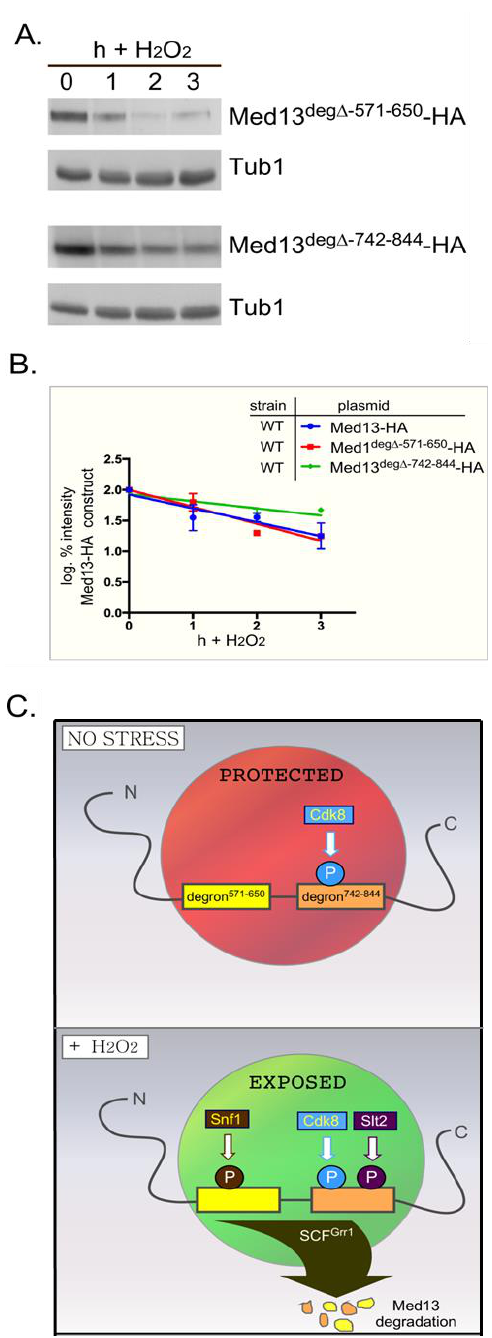
FIGURE 8: Either Med13 degron is sufficient for Med13 degradation. (A) med13 ∆ (RSY1701) cells harboring either Med13 571-650deg∆- HA (pKC805, upper panels) or Med13 742-844deg∆- HA plasmids (pKC814, lower panels) were treated with 0.4 mM H 2 O 2 for the timepoints indicated and Med13 deg∆- HA levels analyzed by Western blot. Tub1 levels were used as a loading control. (B) Degradation kinetics of the results shown in (A). Values represent averages ± SD from a total of at least two Western blots from independent experiments. For clarity, the degradation kinetics of wild-type Med13-HA from previous experiments was included. (C) Model depicting how two SCF Grr1 phospho-degrons mediate the destruction of Med13 following H 2 O 2 stress. In unstressed cells cyclin C-Cdk8 phosphor- ylates degron 742-844 [9] but both degrons are protected by an